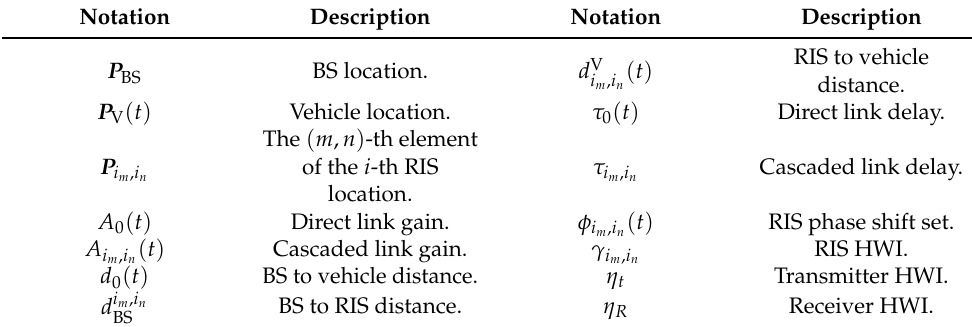
Figure 1. A multi-RIS-assisted HSC system. K = 2. Note that the real-time phase shift set is sent to RISs through feedback links. Table 3. Notations of system model